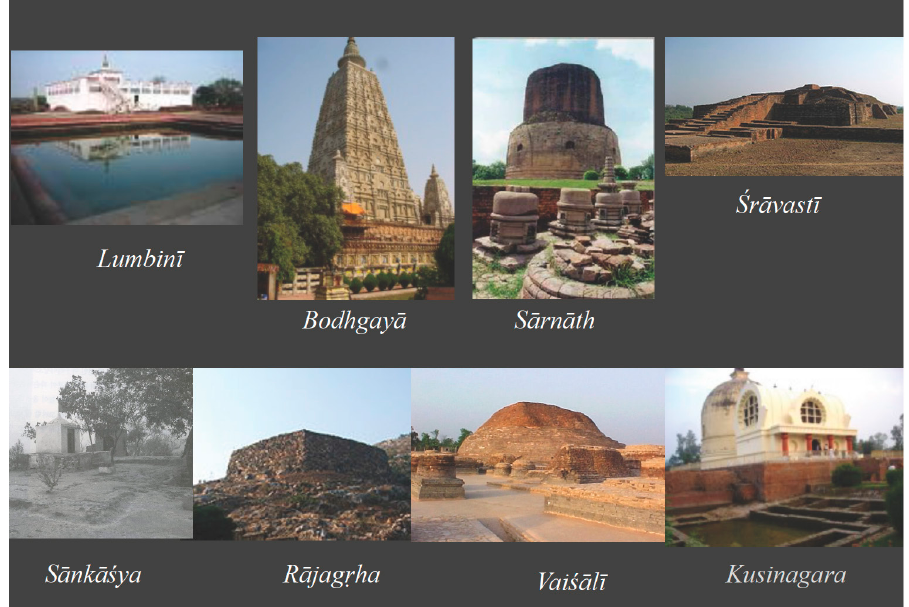
Figure 8. Eight Great Sacred Places (Sk. a ṣṭ amah ā sth ā na ) in present-day India and Nepal. Part of the motivation pertains to the long tradition of Buddhist pilgrimage in East Asia. These eight Indian sacred places were highly desirable pilgrimage destinations for East Asian